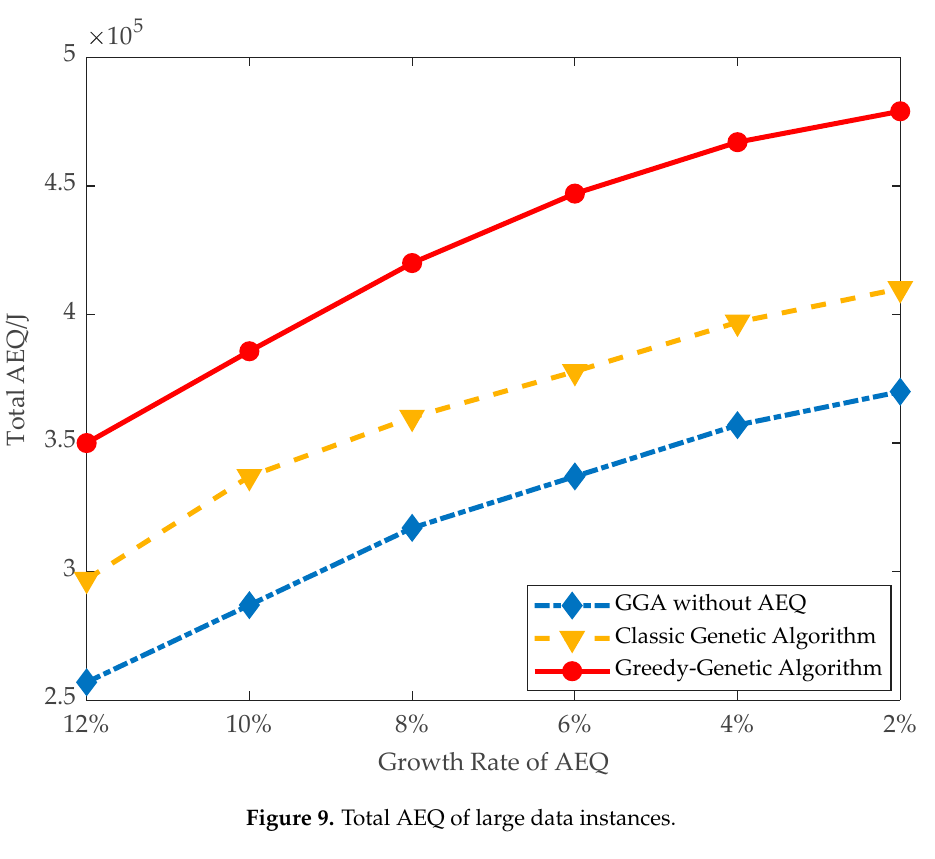
Figure 9. Total AEQ of large data instances.